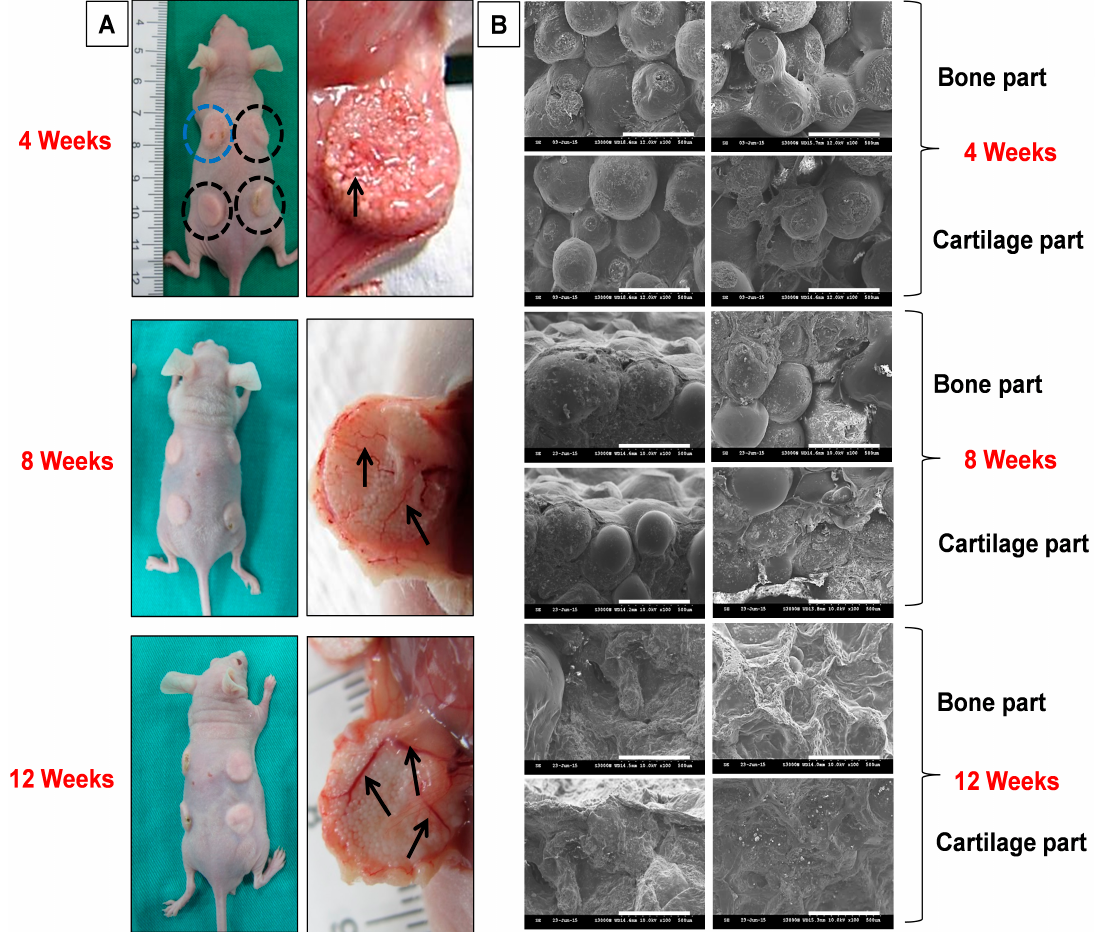
Figure 11. The gross views ( A ) and SEM images ( B ) of acellular OC scaffolds (control) and cell-seeded OC scaffolds (sample) harvested from nude mice 4, 8, and 12 weeks post-implantation. The blue and black circles indicate the control and the sample, respectively. Black arrows indicate blood vessel formation on scaffolds in ( A ); BMSCs and chondrocytes were co-cultured in OC scaffolds and bone and cartilage parts of scaffolds are observed by SEM in ( B ). Bar = 500 m.